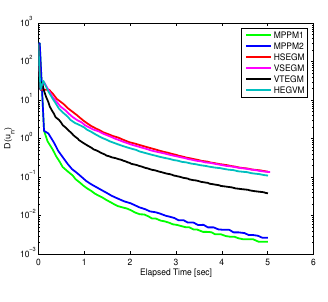
Figure 9. Methods for Example 3 with m = 4. Number of iterations is 43, 52, 56, 50, 89, 56,